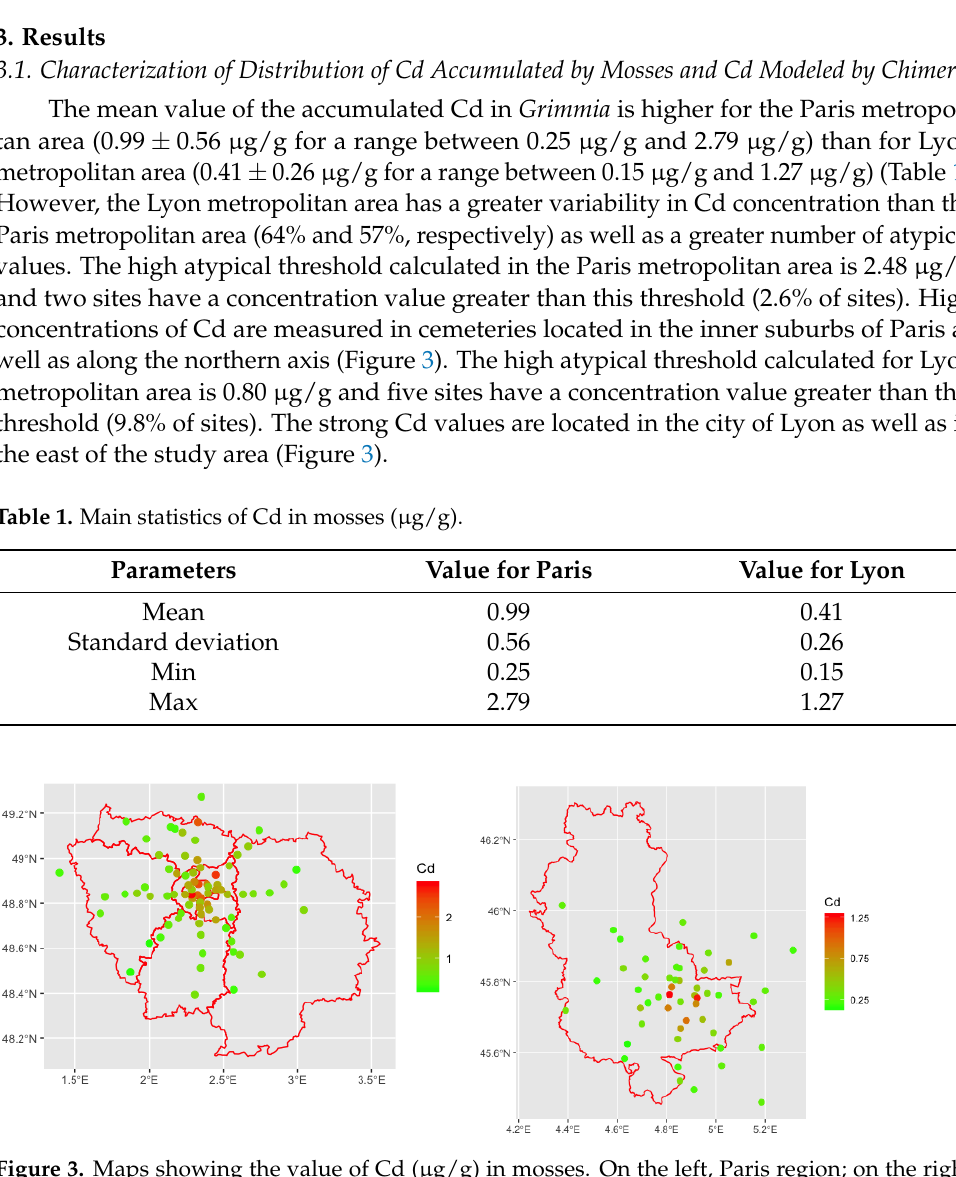
Figure 3. Maps showing the value of Cd ( µ g/g) in mosses. On the left, Paris region; on the right, region of